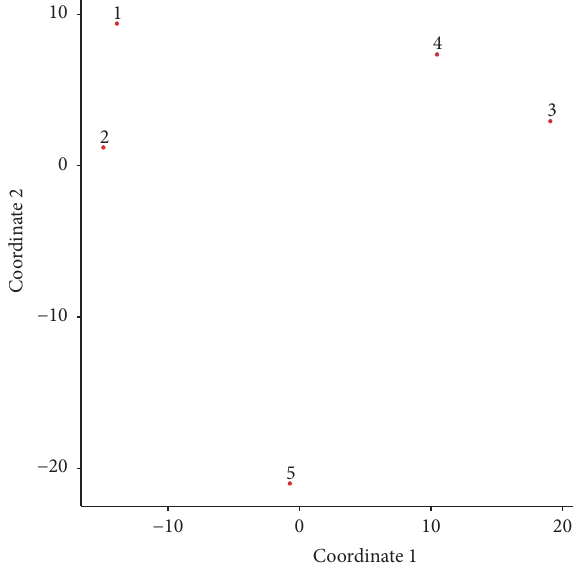
Figure 3: GPA-MDS plot for the simulation study.